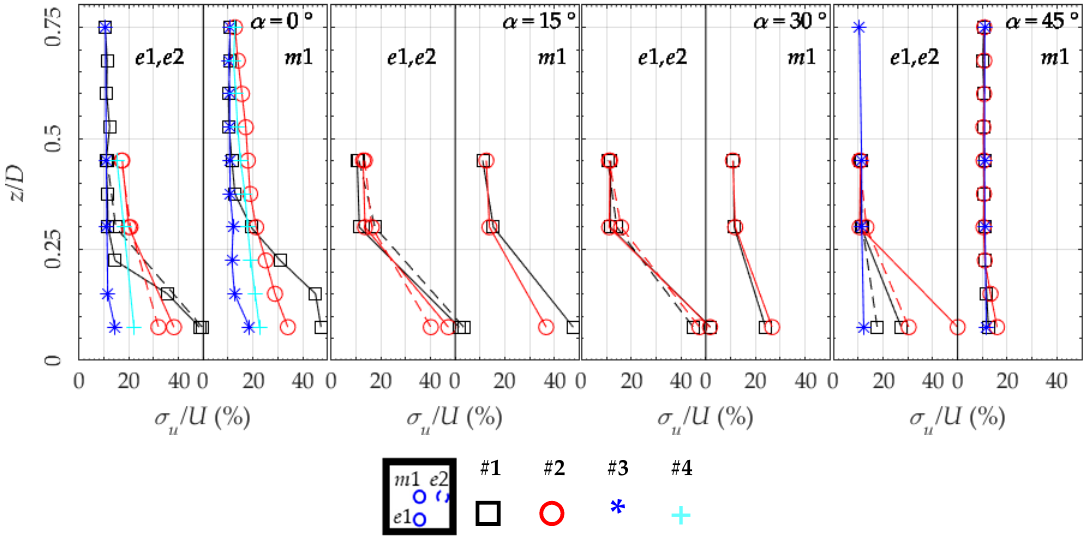
Figure 11. Longitudinal turbulence intensity I u at windward ( c 1, c 2) and leeward ( c 3) corner locations. Symbols as indicated in the legend, for the configurations #1, #2, #4 and wind directions.